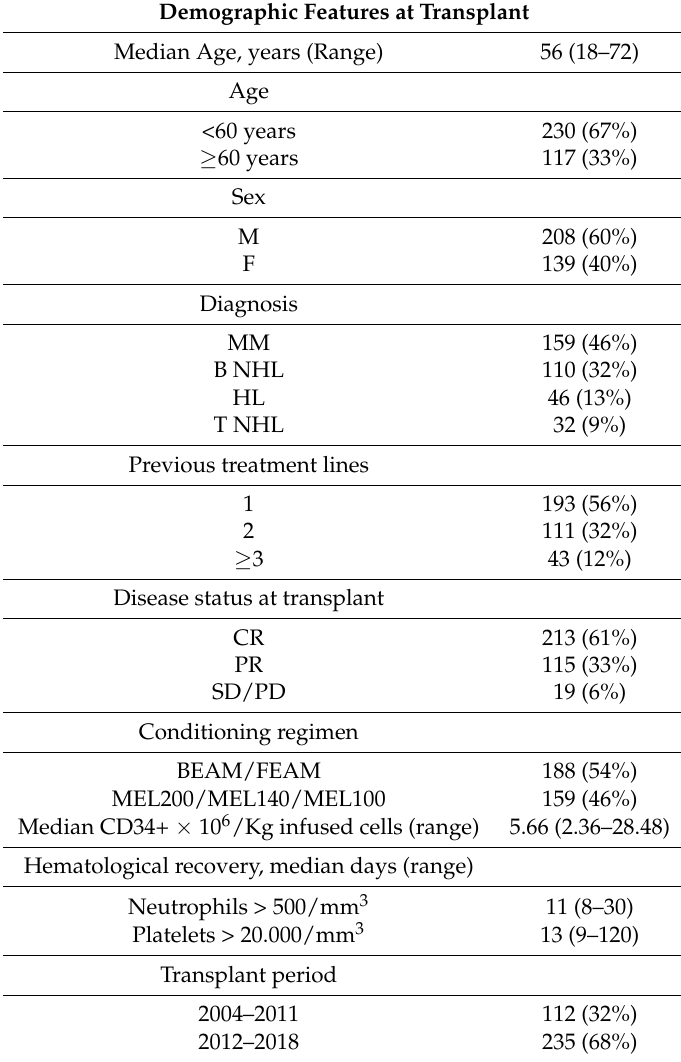
Table 1. Features of 347 ASCTs performed in myeloma and lymphoma patients in our institution between May 2004 and April